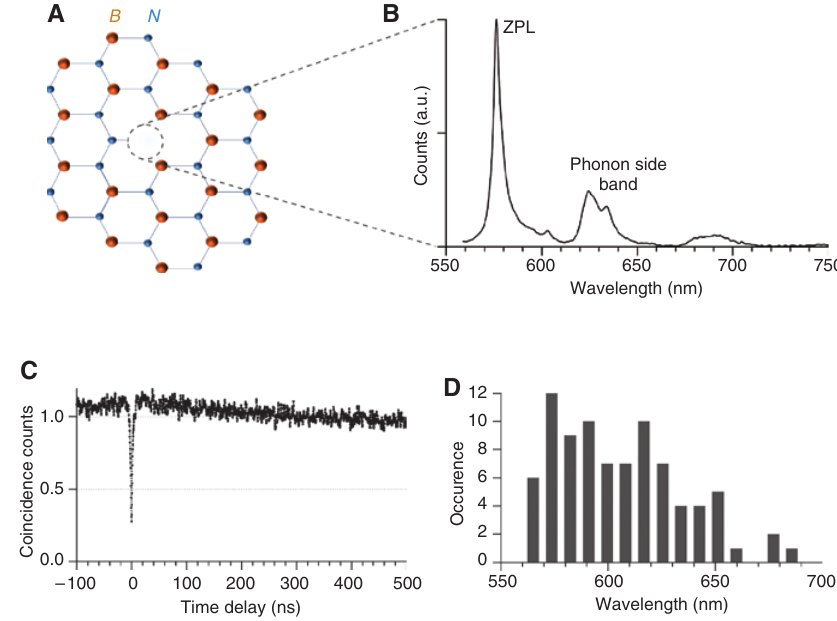
Figure 6: (A) Schematic of the atomic structure of hexagonal boron nitride. The dashed circle shows the structure of an NV in which one N atom is vacant and an adjacent B atom is substituted with N. (B) Typical room temperature spectrum of an SPE associated to an atomic-like defect. (C) Autocorrelation function ( g 2 ( τ )) showing anti-bunching at zero time delay. The histogram is measured using a Hanbury Brown and Twiss setup with continuous wave excitation at 532 nm. (D) Spectral distribution of the ZPL emission for almost 90 individual emitters. The emission energy spans over the 150-nm